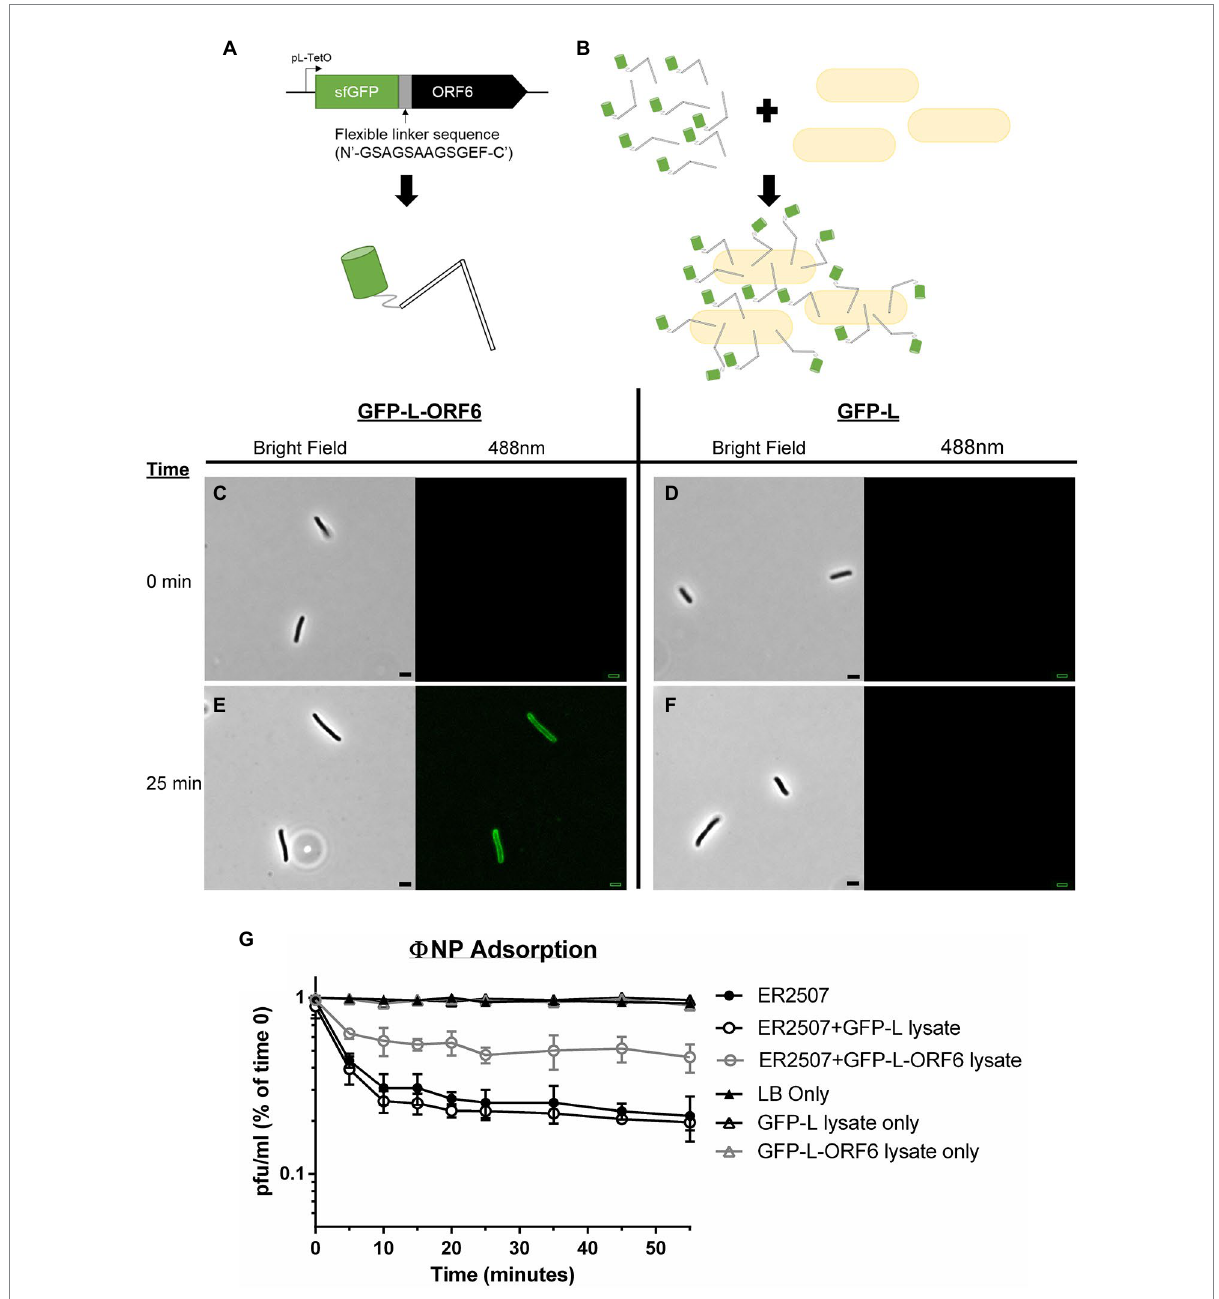
FIGURE 2 Adsorption kinetics and fluorescence assays show that ORF6 encodes the putative RBP of Φ NP. (A) A cartoon depicting the construct utilized to assess ORF 6 binding. ORF6 was recombinantly expressed with a superfolder GFP (sfGFP) fusion tag, linked with a flexible linker sequence (N ′ -GSAGSAAGSGEF-C ′ ), and under control of a pL-TetO Tc repressible promoter (named sfGFP-L-ORF6). As a control an identical construct lacking ORF6 was built (named GFP-L). (B) Cartoon depicting fluorescence localization to the surface of host bacteria (not to scale). (C-F) Fluorescence localization assay of crude sfGFP-L-ORF6 lysate (A,E) and control crude GFP-L lysate (D,F) using host bacteria E. coli K12 strain ER2507 under both brightfield and 488 nm emission. Notably, at 0 min (C,D) no background fluorescence is seen in either sample. Following 25 min (E,F) fluorescence can be seen localized to the periphery of bacteria in the sample containing crude sfGFP-L-ORF6 lysate (E) while none is seen with samples containing GFP-L crude lysate (F) . (G) Representative graph showing the mean results of triplicate adsorption assays of Φ NP over 55 min onto E. coli K-12 strain ER2507 in the presence of no lysate, crude sfGFP-L-ORF6 lysate, or crude sfGFP-L lysate with error bars denoting SD. Also shown are the results of E. coli K-12 strain ER2507 in the presence of no lysate, crude sfGFP-L-ORF6 lysate, or crude sfGFP-L lysate with no addition of Φ NP. As can be seen, addition of GFP-L-ORF6 lysate to of E. coli K-12 strain ER2507 in the presence of Φ NP greatly reduces Φ NP adsorption kinetics. The left axis shows phage left unabsorbed as a percentage of phage at time 0 min in